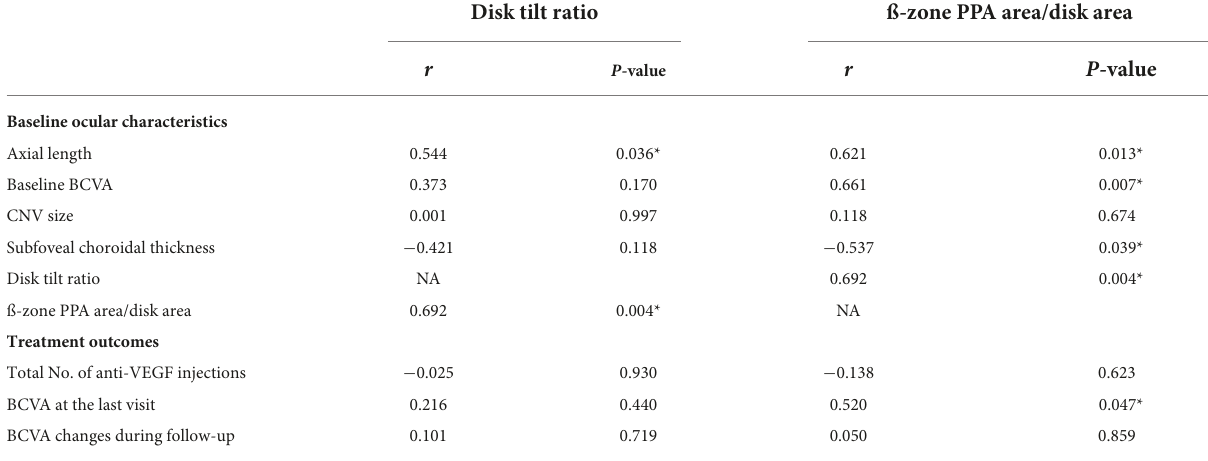
TABLE 2 Correlation between optic disk features and baseline ocular characteristics and treatment outcomes.